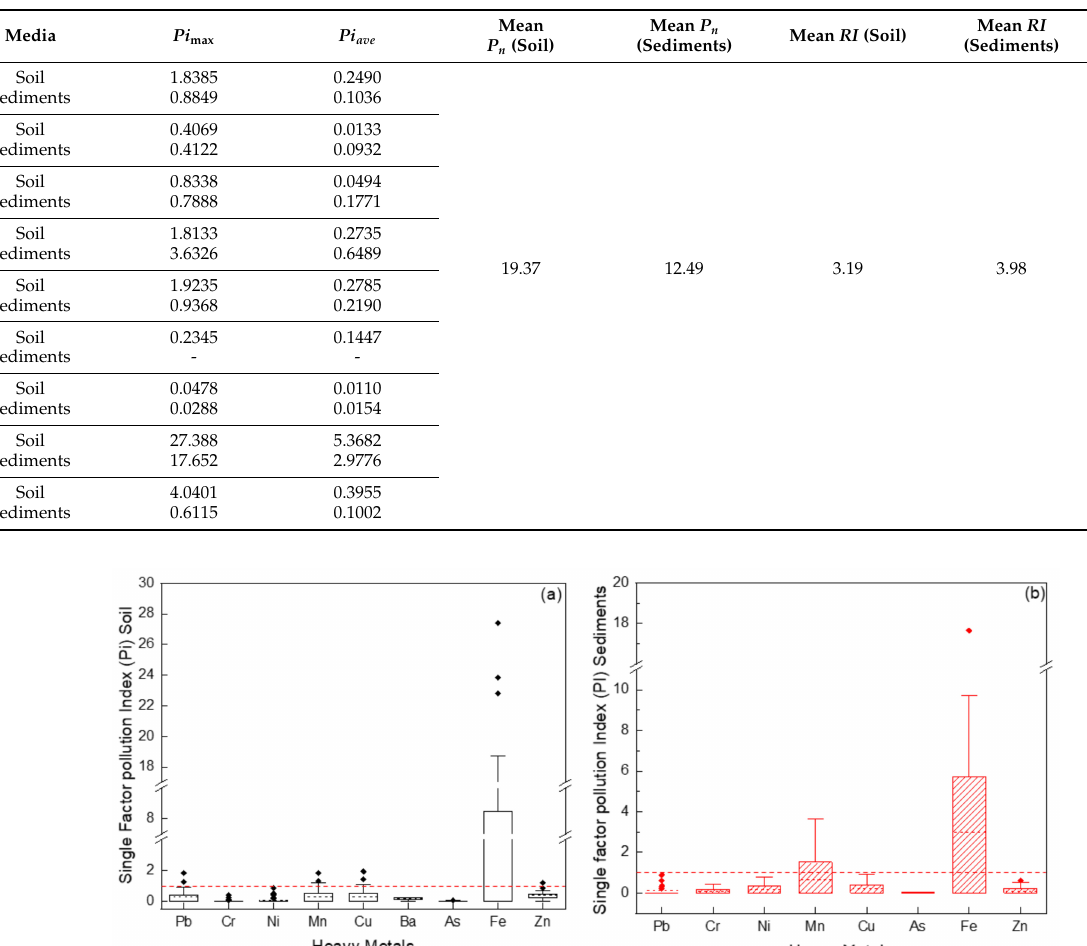
Table 3. Single Factor Index, NPI, and Pollution Risk Index for Soil and Sediments.